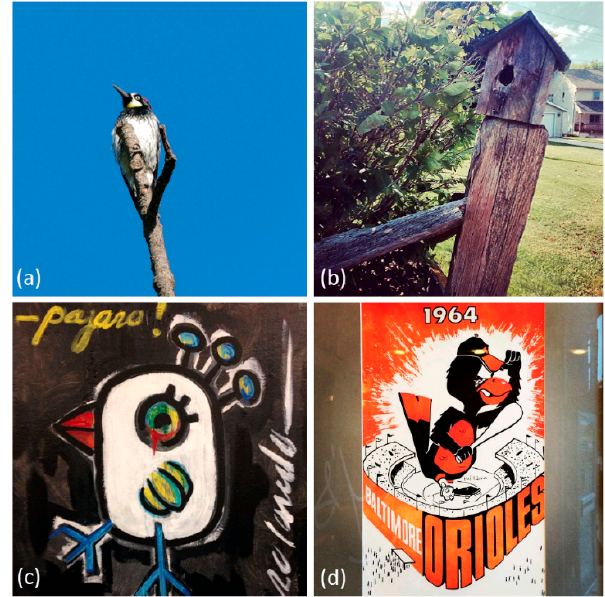
Figure 5. Only metadata detected bird photographs. ( a ) Acorn Woodpecker, ( b ) @fence #birdhouse #wood #lynnfriedman, ( c ) New piece! One if the largest paintings I have done of my birds! 30" × 40”, and ( d ) #birdland #masnorioles.